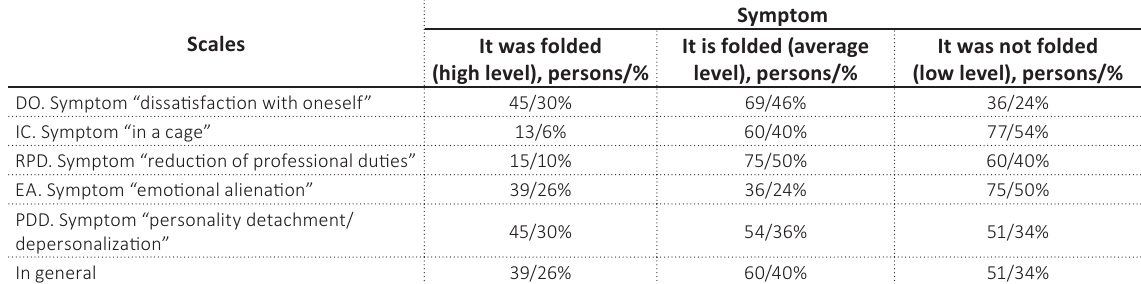
Table 4. The level of professional emotional burnout among IT employees in Ukraine according to the questionnaire “Express diagnostics of the level of emotional burnout”